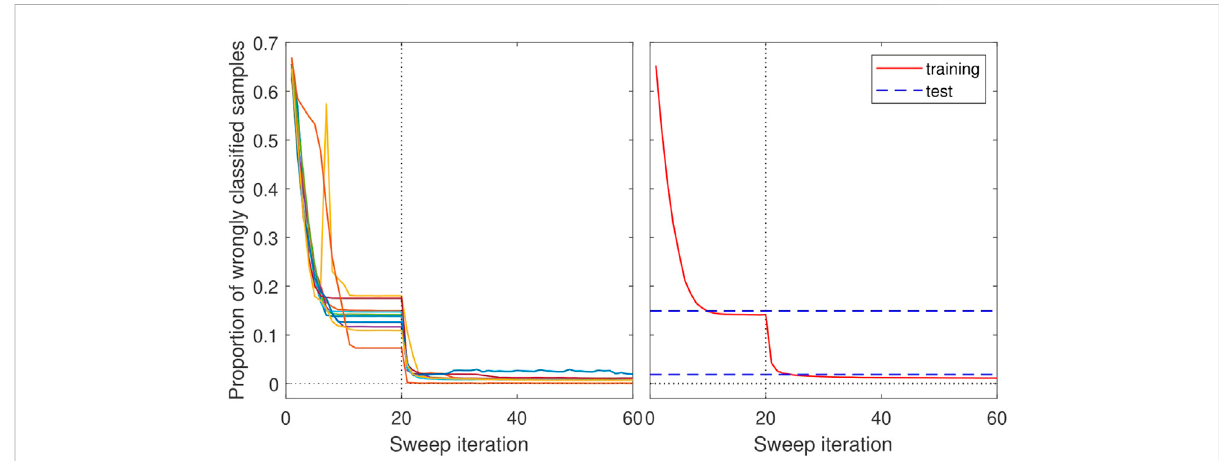
FIGURE 9 (left) Results of training TTN and MERA for the height classi fi cation problem, displaying how much of training set is wrongly classi fi ed as a function of the number of optimization sweeps performed. The fi rst 20 sweeps are performed while keeping trivial disentanglers u , such that underlying the network is a TTN, while the u are then “ switched on ” for the remaining sweeps such that the network becomes a MERA. The fi gure displays results from 10 different trials, where each trial starts with a randomly generated training set and randomly initialized network. (right) Average results of the training data from 100 trial runs (after discarding the 10 worst trials). Dashed lines show the average generalization error computed from applying the trained TTN and MERA applied to a randomly generated test set. For TTN we get average training/test errors of 14.15% and 14.91%, while for MERA we get average training/test errors of 1.13% and